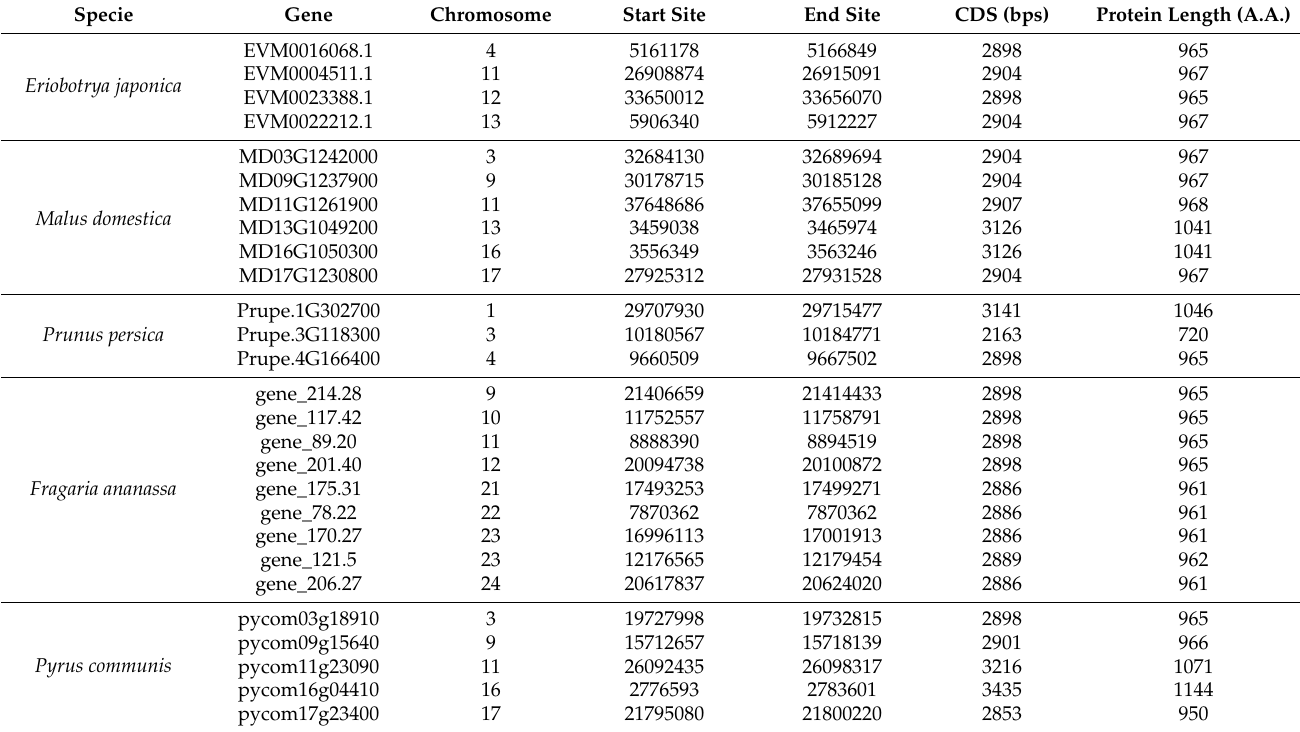
Table 2. The basic information about PEPC genes in five Rosaceae species.